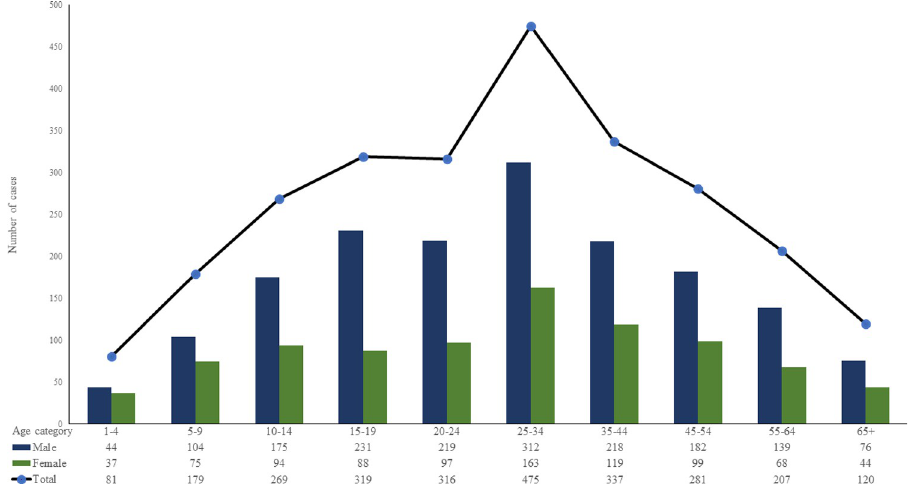
Fig 4. Distributions of the 2,584 cases over the 21-year period divided by age groups and sex. Cases were reported over all ages (range, 1 to 98 years; mean/median, 31/27 years), but were least frequent between birth and 4 years of age. Male and females aged 25 to 34 years, were the most frequently hospitalized. A statistically significant association was found between the frequency of cases and the age category (p < 0.001), with the age categories of 15–19 and 25–34 years being the ones with the highest rates of infection compared to age categories 1–4 and over 65 years, having the lower infection rates.